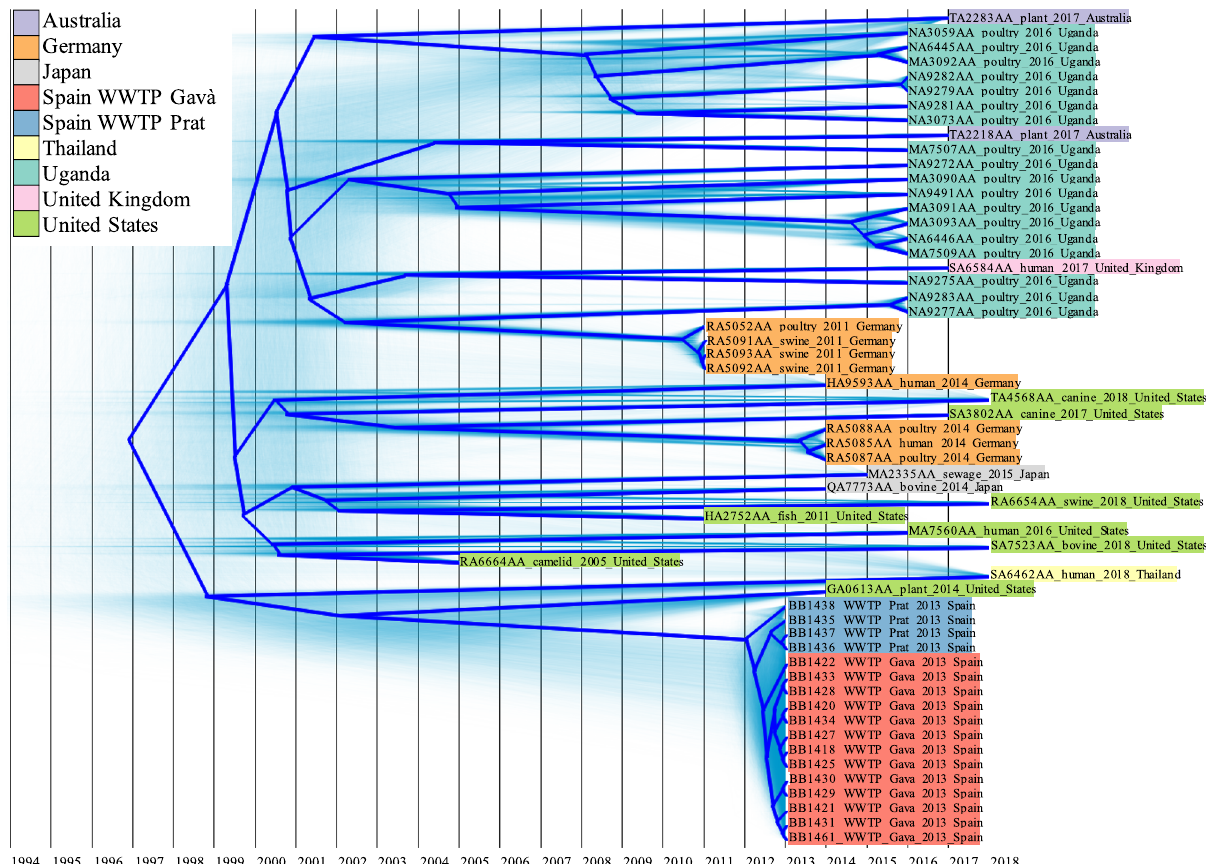
Fig. 6 Phylogenetic tree of E. coli ST1196. Probable phylogenetic reconstructions are shown with shaded green trees. Summarized root-canal tree is indicated by thick blue tree. Grid indicates the years to locate the divergent events through the evolutionary history of the ST. The name of the isolate, the source, the year of isolation, and the country of origin are indicated in the tips of the tree and colored according to the country of origin as shown in the